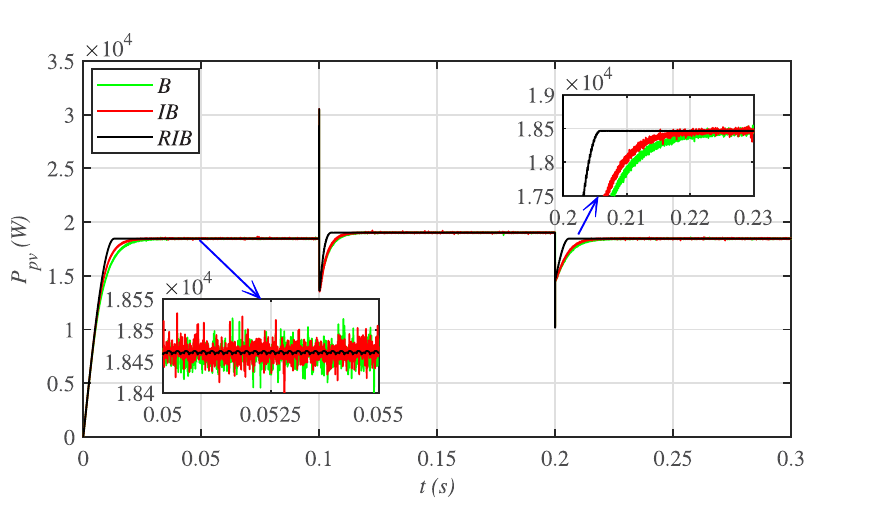
Fig 12. PV array comparative powers under case